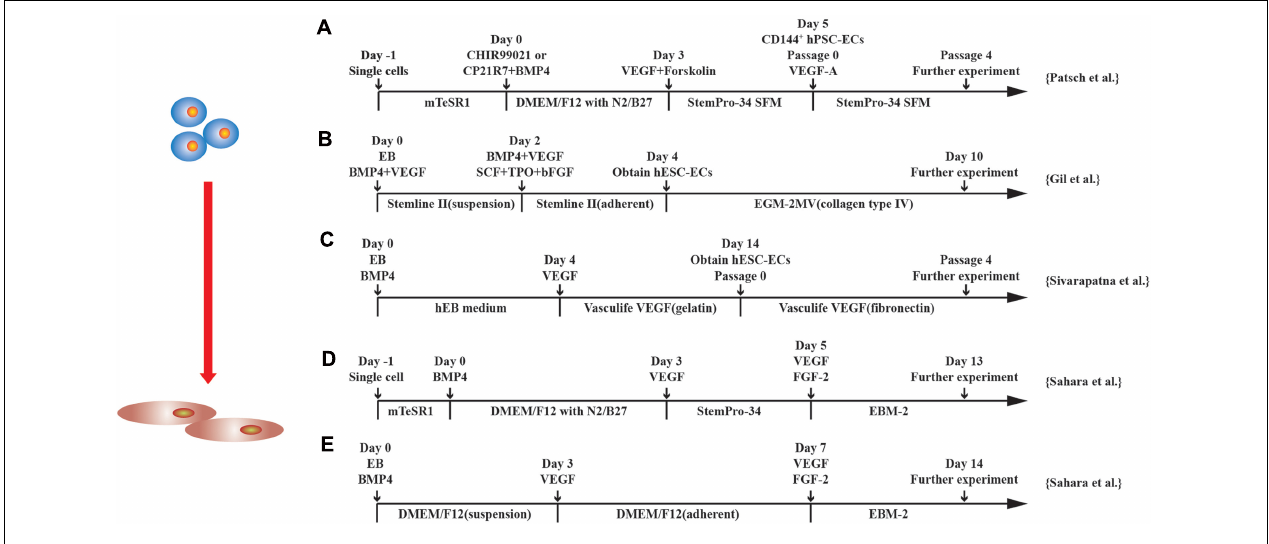
FIGURE 3 | Schematic diagram of differentiation of hPSCs into endothelial cells. (A) Schematic diagram of chemically defined protocol. Cells were differentiated to mesoderm by GSK3 inhibition or BMP4 treatment and treated with VEGF to induce ECs. (B,C) Schematic diagram of two-stage treated EB protocols. (D,E) Schematic diagram of single-cell and EB protocols, respectively, and both methods applied a two-stage cytokine treatment